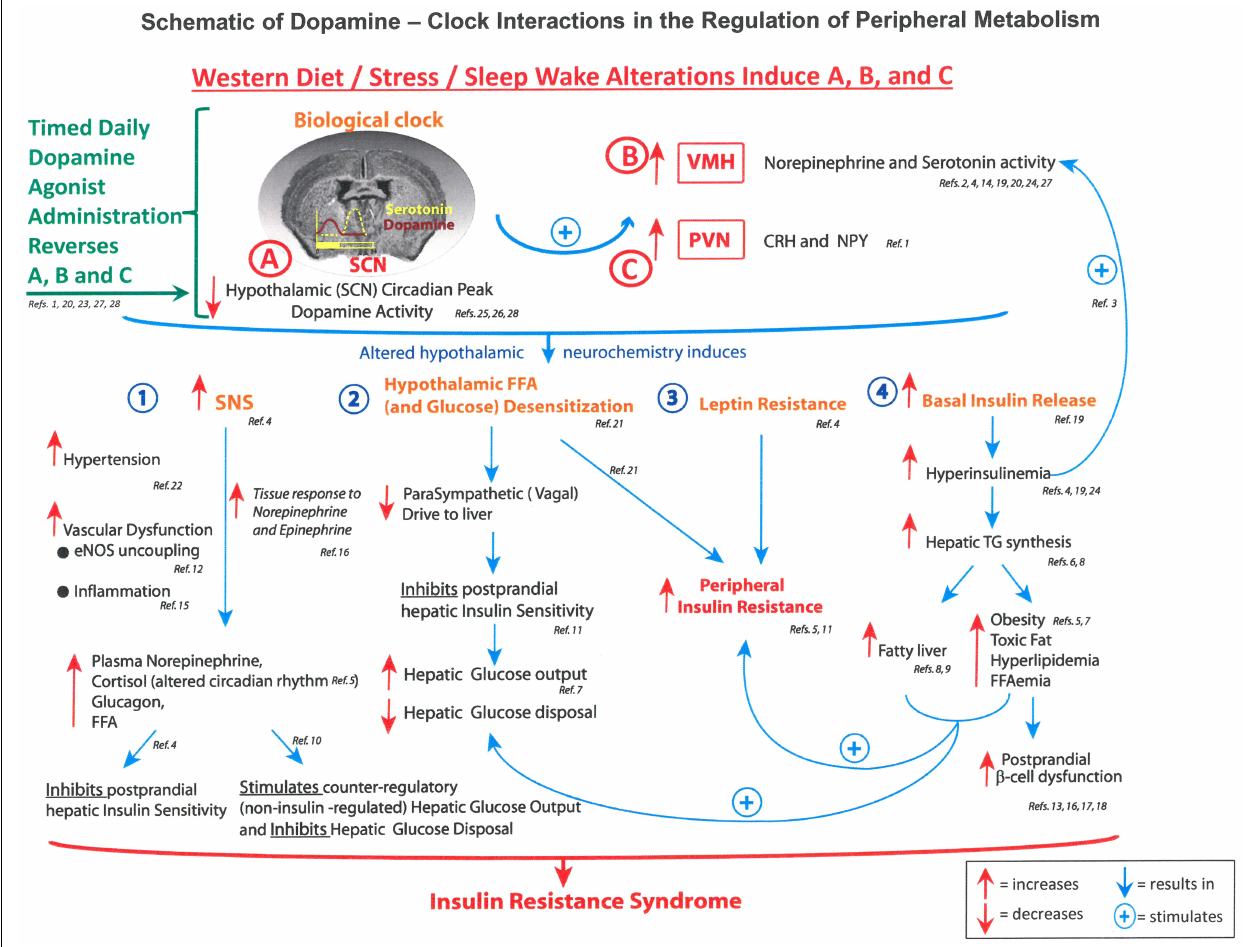
FIGURE 1 | Schematic of dopamine – clock interactions in the regulation of fuel metabolism. Figure illustrates the hypothalamic clock with decreased suprachiasmic nuclear (SCN) early morning peak of dopamine activity and enhanced activity of the paraventricular nucleus (PVN), which increase autonomic tone and the paraventricular nucleus to raise levels of corticotrophin releasing hormone (CRH). The consequences include activation of the sympathetic nervous system (SNS) hypothalamic and glucose sensitization reducing parasympathetic (vagal drive) to the liver and resistance to both leptin and insulin. CRH, corticotrophin releasing hormone; eNOS, endothelial nitric oxide synthase; FFAs, free fatty acids; NPY, neuropeptide Y; PVN, paraventricular nucleus; SCN, suprachiasmatic nucleus; SNS, sympathetic nervous system; TGs, triglycerides; VMH, ventromedial hypothalamus (Raskin and Cincotta, 2016).